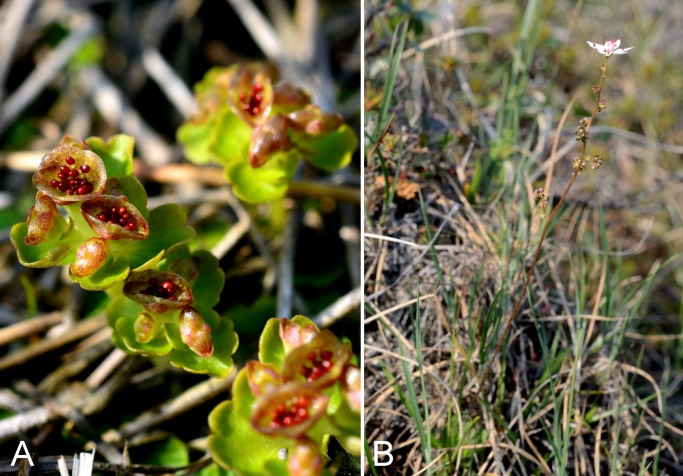
Chrysosplenium rosendahlii and Micranthes foliolosa.Chrysosplenium rosendahlii: (A) inflorescence and fruits, Saarela et al. 4310. Micranthes foliolosa: (B) habit, Saarela et al. 4382. Photographs by P. C. Sokoloff (A) and R. D. Bull (B).